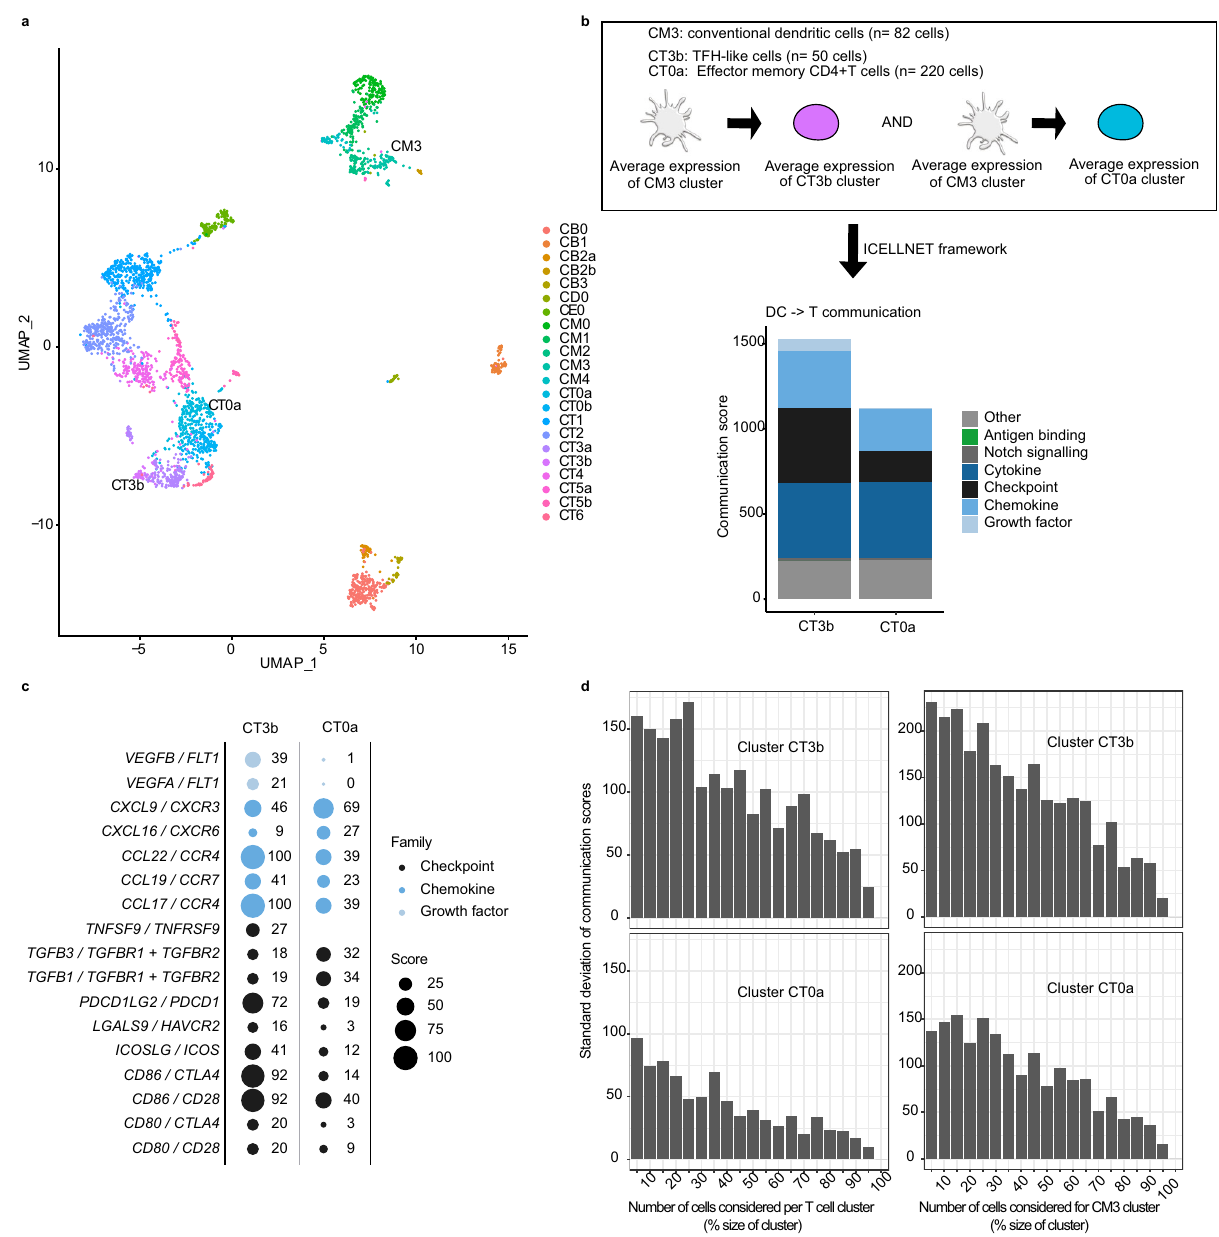
Fig. 4 Evaluation of cell-to-cell communication potential between dendritic cells and T-cell subpopulations in lupus nephritis single cell data. a Uniform Manifold Approximation and Projection (UMAP) visualization of the lupus nephritis dataset. 22 clusters were previously identi fi ed by the authors and their annotations are displayed on the right. Cell identity of each cluster can be found in the original article 20 . b ICELLNET framework applied on speci fi c cluster to assess DC-T intercellular communication. Average expression pro fi les were computed from the single-cell data matrix counts for each cluster to then compute intercellular communication score. Barplots are displaying the contribution of the different communication molecules families to the communication scores. c Balloon plot representing speci fi c individual interaction scores that differ from at least 10 between the two conditions (cutoff chosen for clarity purpose) for interaction belonging to either chemokine, checkpoint, or growth factor families of molecules. d Assessment of communication score variability when subsampling DC or T cluster. Cells were randomly selected for CT0a and CT3b cluster (left) or CM3 cluster (right) (number of cells selected according to their respective cluster size). Communication scores were computed with the other complete cluster (CM3 for left, T cell cluster for right). Standard deviations of the communication scores are displayed on the graphs ( n = 20 random selection of cells). Some schematic art pieces were used and modi fi ed from Servier